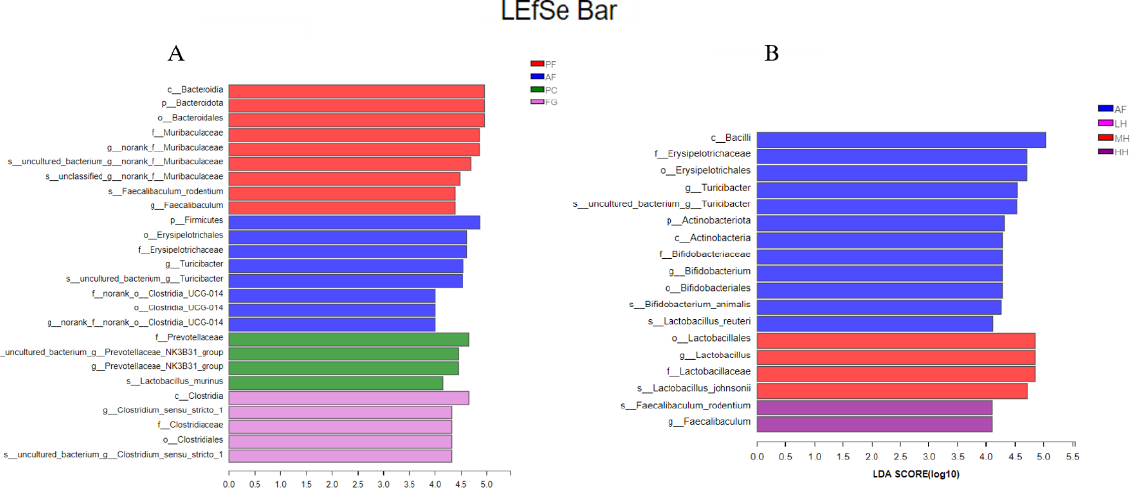
Figure 3. Dominant taxa in the mouse gut microbiota, with a linear discriminant analysis (LDA) score > 4.0, p < 0.05. ( A ) Comparative linear discriminant analysis Effect Size (LEfSe) analysis of mice in the PF, AF, PC, and FG groups ( B ) Comparative LEfSe analysis of mice in the AF, LH, MH, and HH groups. Note: p: phylum, c: class, o order, f: family, g: genus; different colors indicate different groupings. PF represents the pair – fed control group. AF represents the alcohol – fed model group. PC represents the positive control group. LH represents the low – dose citrus honey group. MH rep- resents the medium – dose citrus honey group. HH represents the high – dose citrus honey group. FG represents the fructose syrup group.